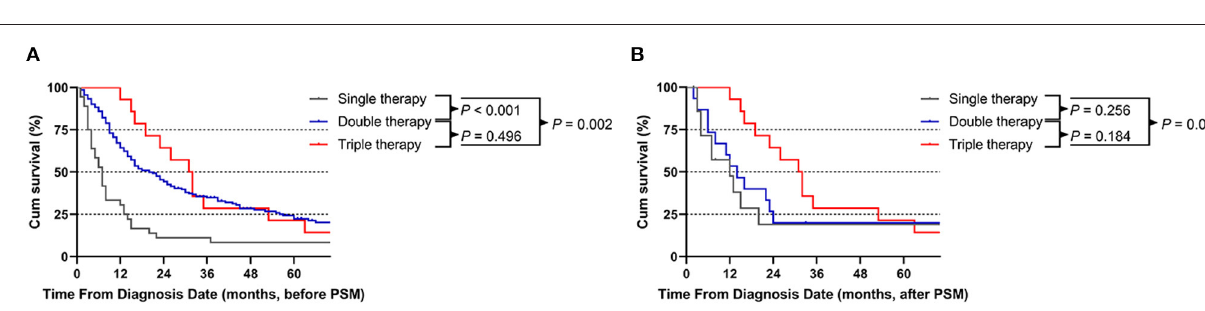
2-year OS rates of 64.3, 71.5, and 50.6%, respectively,